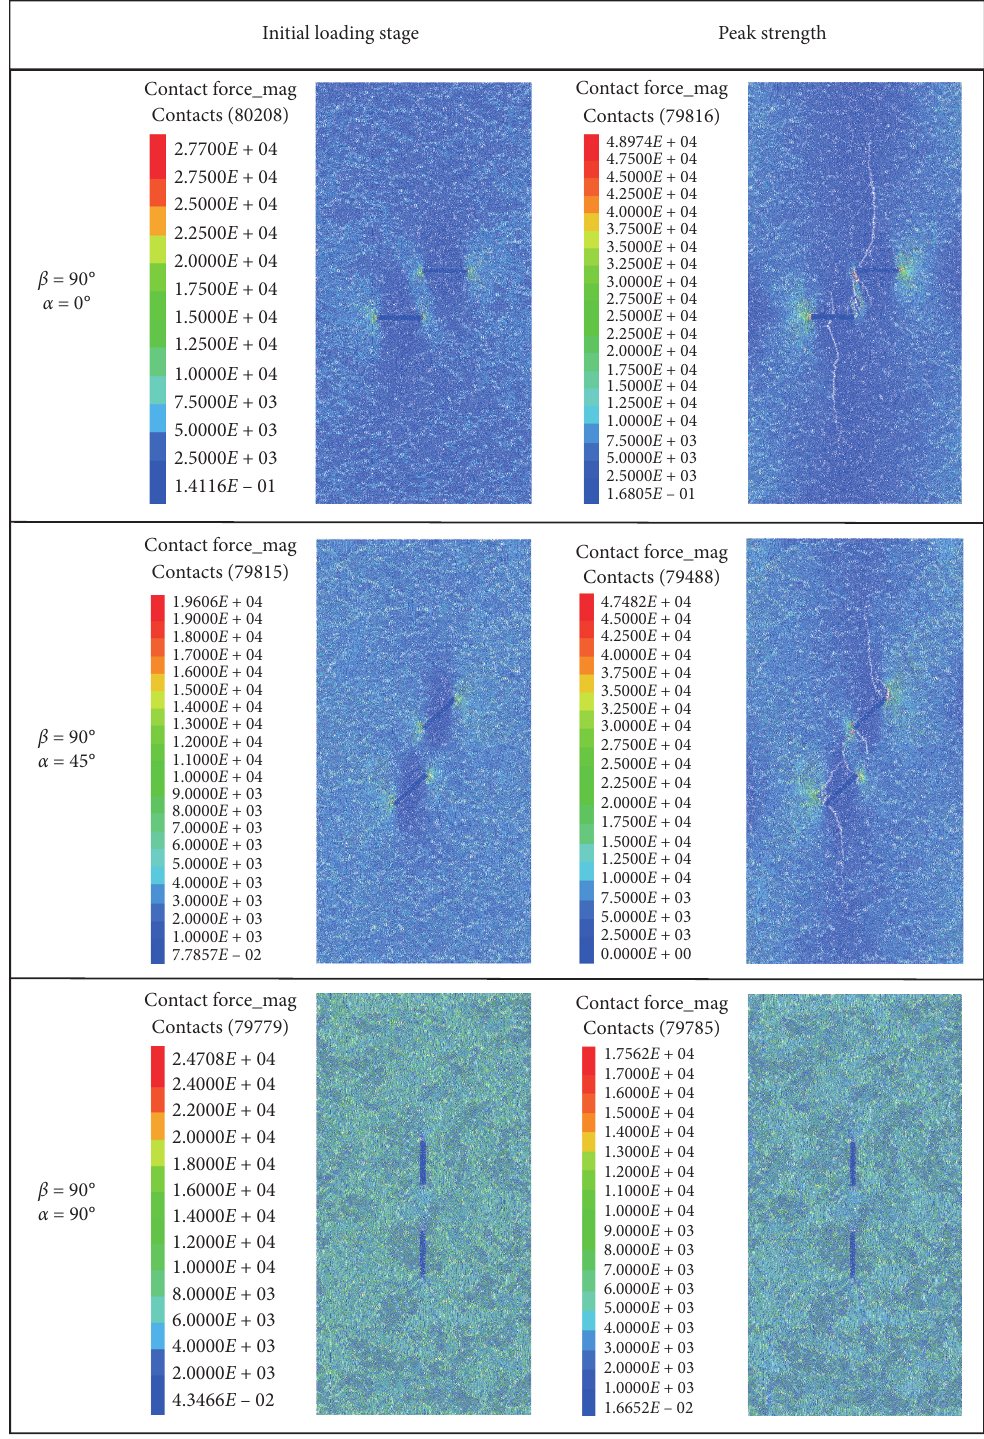
Figure 9: Contact force of samples containing infilled flaws with the same β of 90 ° and different α of 0 ° , 45 ° , and 90 °